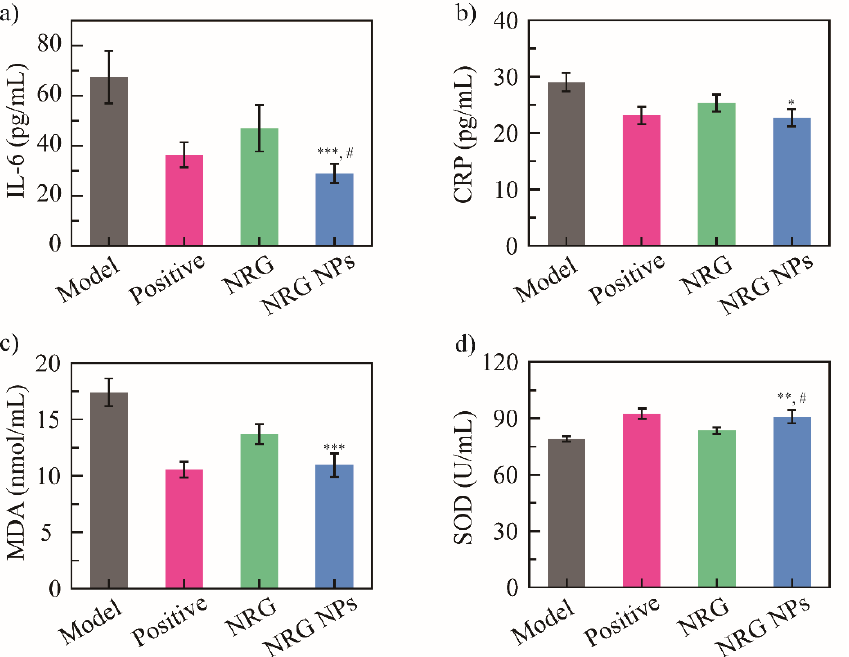
Figure 5. Anti-inflammatory activity: IL-6 biomarker level ( a ), and CRP biomarker level ( b ); antioxidant activity of NRG NPs: MDA biomarker level ( c ), and SOD biomarker level ( d ) ( n = 5). *** p < 0.001, ** p < 0.01, * p < 0.05 vs. blank model group, # p < 0.05 vs. NRG group.